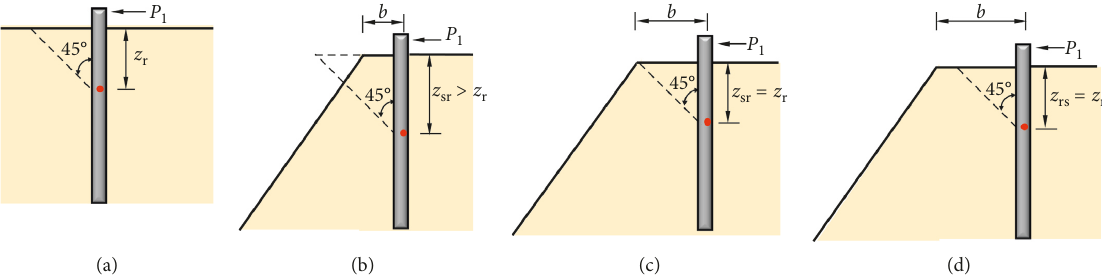
Figure 9: The failure wedge of soil around pile with different distance from pile center to slope: (a) b � ∞ ; (b) b < b